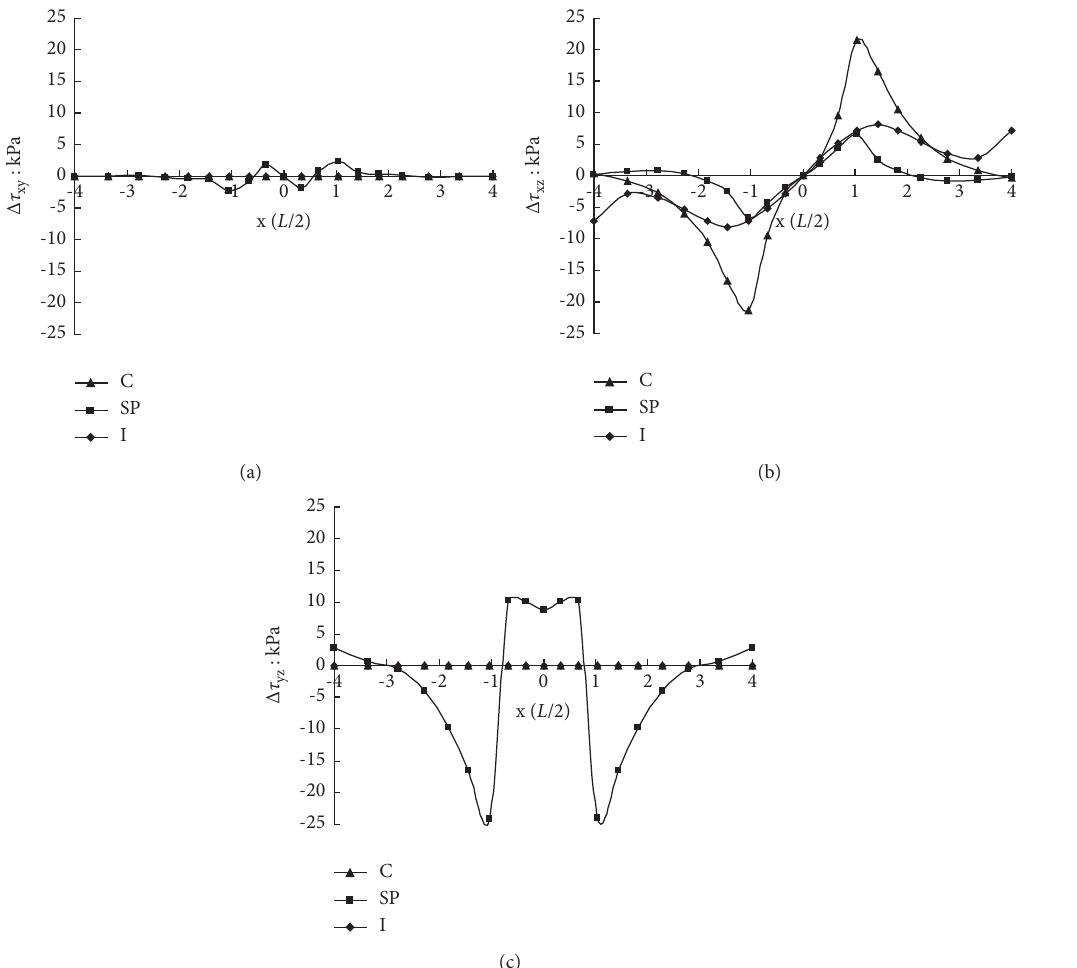
Figure 8: (a) Δ τ xy , (b) Δ τ xz , and (c) Δ τ yz for various soil elements along tunnel axis after excavation for case C. Monitored elements: C, crown; SP, left spring line or right spring line; and I,